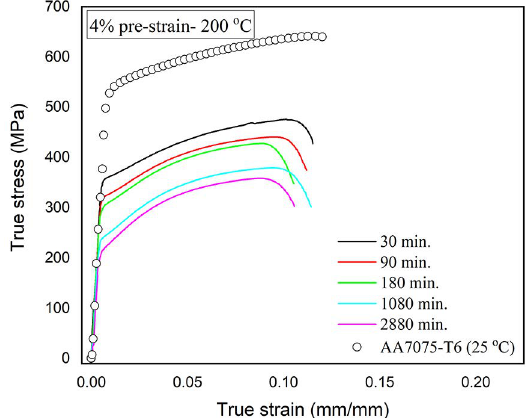
Figure 14. True stress vs. true strain for different aging time at 200 ºC (4% pre-strain)